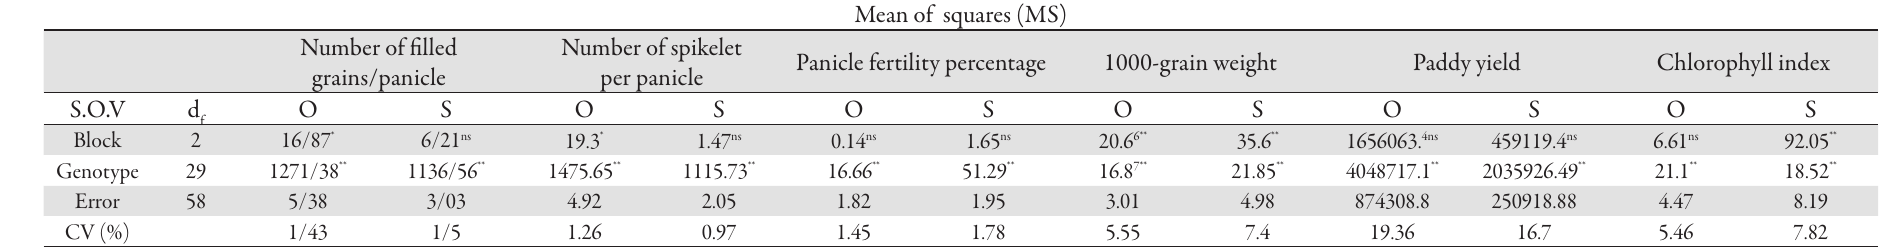
Tab. 1. Analysis of variance of studied traits in 30 rice cultivars under two irrigation regimes optimum irrigation (O) and drought stress(S)-Continous